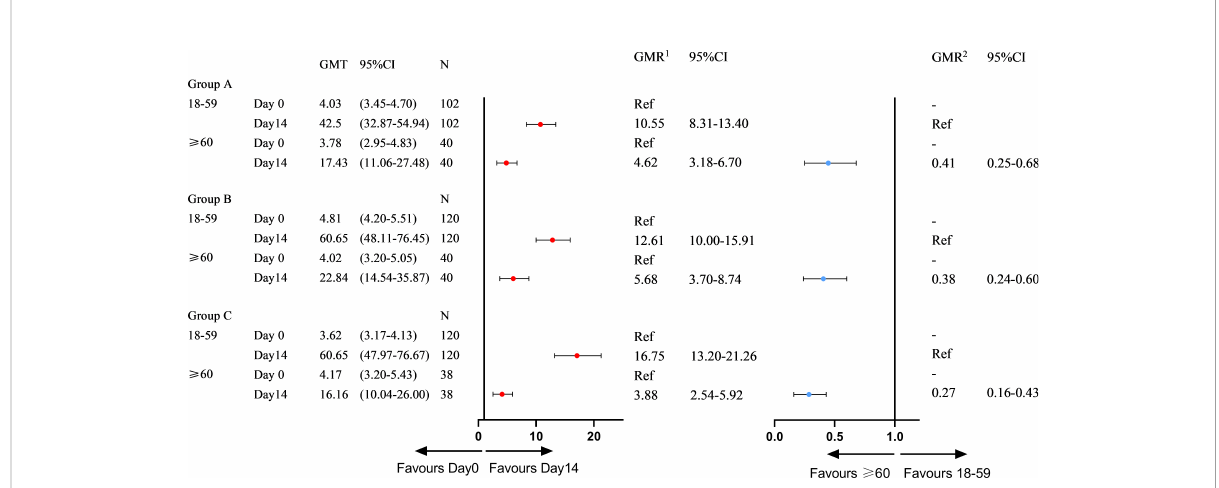
FIGURE 4 Subgroup immunogenicity analysis by age on Day 0 and Day 14 for three prime-boost intervals. GMT, geometric mean titer; N, number of per- protocol set in immunogenicity analysis; GMR 1 , geometric mean ratio on Day 14 vs Day 0 in different age subgroups; GMR 2 , geometric mean ratio of ≥ 60 vs 18-59 years of age on Day 14; CI, con fi dence